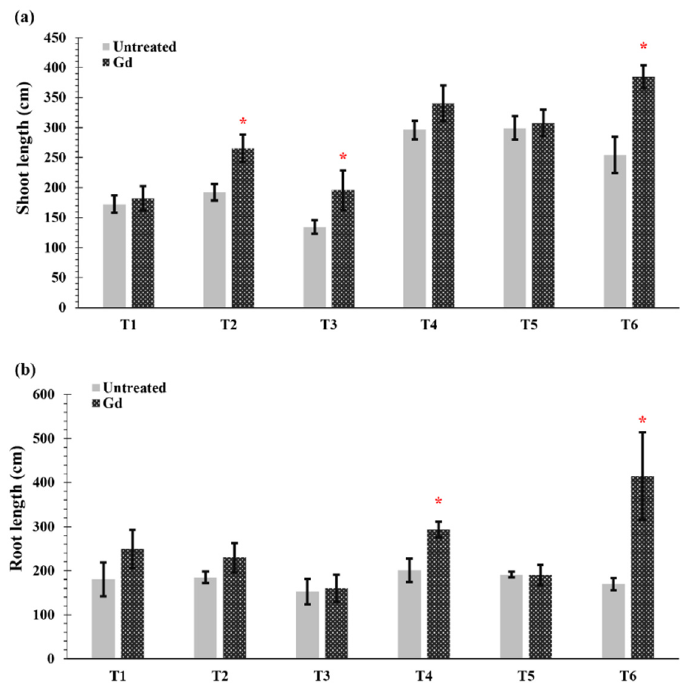
Figure 2. Evaluating the effects of severe water stress (35%-WHC; T1), moderate water stress (50%-WHC; T2), severe nitrogen stress (0 mg N pot − 1 ; T3), moderate nitrogen stress (150 mg N pot − 1 ; T4), combination of severe water stress and moderate nitrogen stress (35% WHC and 0 mg N pot − 1 ; T5), and combination of moderate water stress and moderate nitrogen stress (50% WHC and 150 mg N pot − 1 ; T6) on ( a ) shoot length and ( b ) root length of maize plants inoculated with Gluconacetobacter diazotrophicus Pal5 (Gd) in comparison with untreated plants. Bars represented means of three ( n = 3) replicates with standard errors (SEs). * above bars indicate significance at p < 0.05 and bars without any * are non-significant ( p > 0.05).